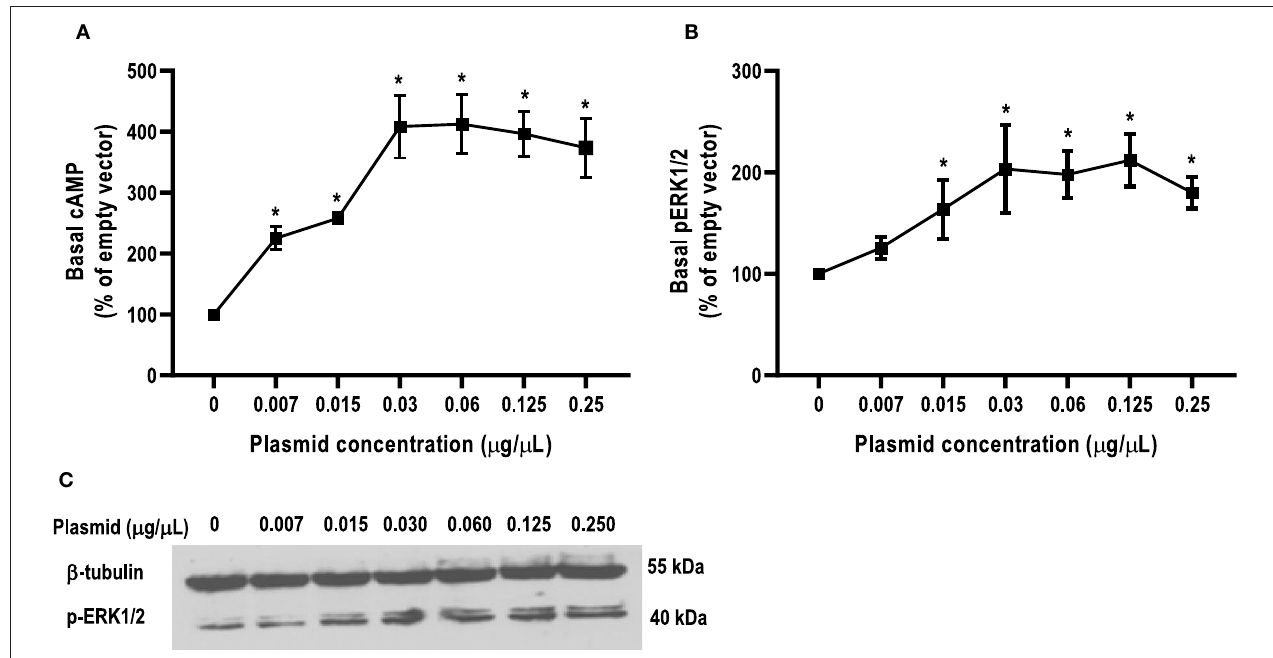
FIGURE 6 | Constitutive activities of caMC4R in cAMP and ERK1/2 pathways. HEK293T cells were transfected with increasing concentrations of caMC4R plasmids. Cells transfected with empty pcDNA3.1 vector was considered as control group. (A) cAMP levels were were measured by RIA. The curve was made with data from three independent experiments. (B,C) The ERK1/2 phosphorylation levels were detected by western blot. Values are expressed as mean ± SEM ( n = 3). Asterisk (*) showed significant difference of cAMP and pERK1/2 levels compared with control group ( P < 0.05) (One-way ANOVA followed by Tukey-test).